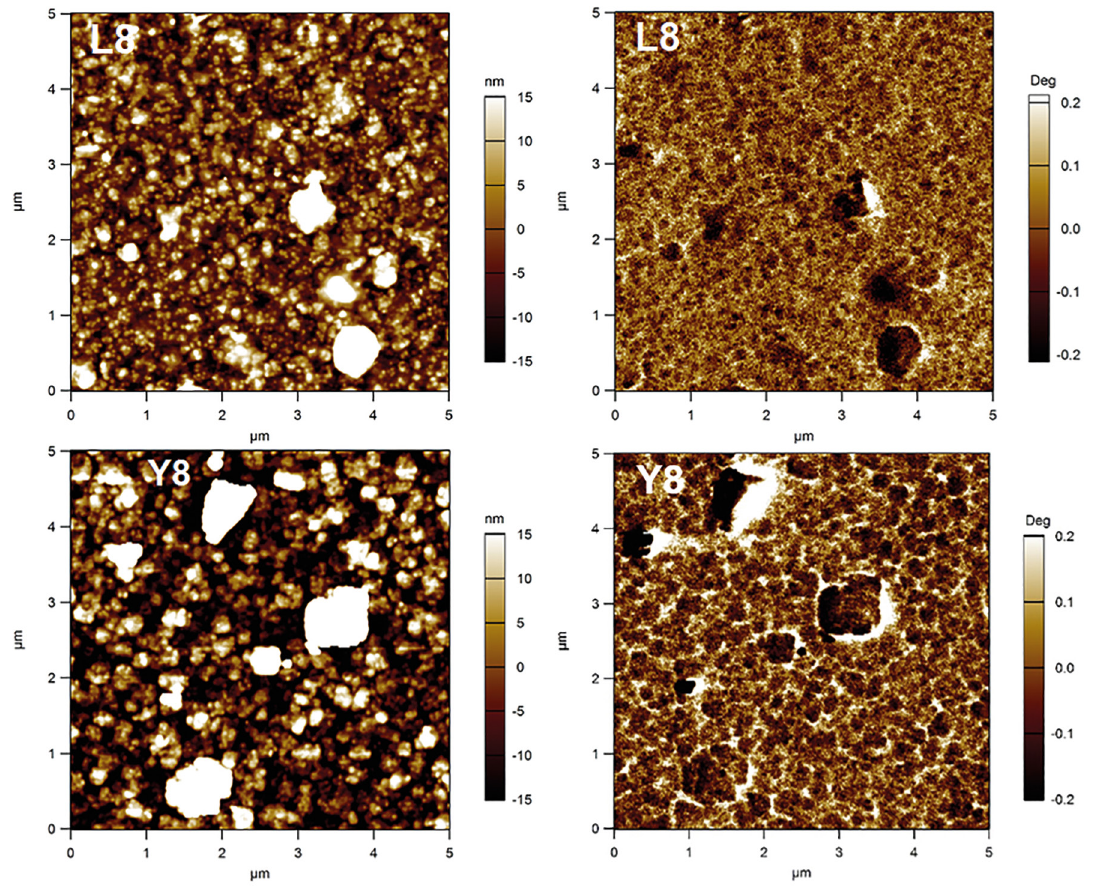
Figure 3. Topography obtained by AFM (left column) and the mapping of charge conduction, obtained by phase EFM (right column), for 5μm x 5μm regions of the LCMO (L8) and YBCO (Y8) top layers for the superlattices having 8nm layer of